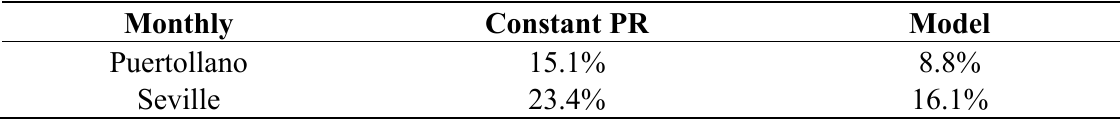
Table 10. Monthly percentage differences between real and predicted monthly EP for the two prediction methods.